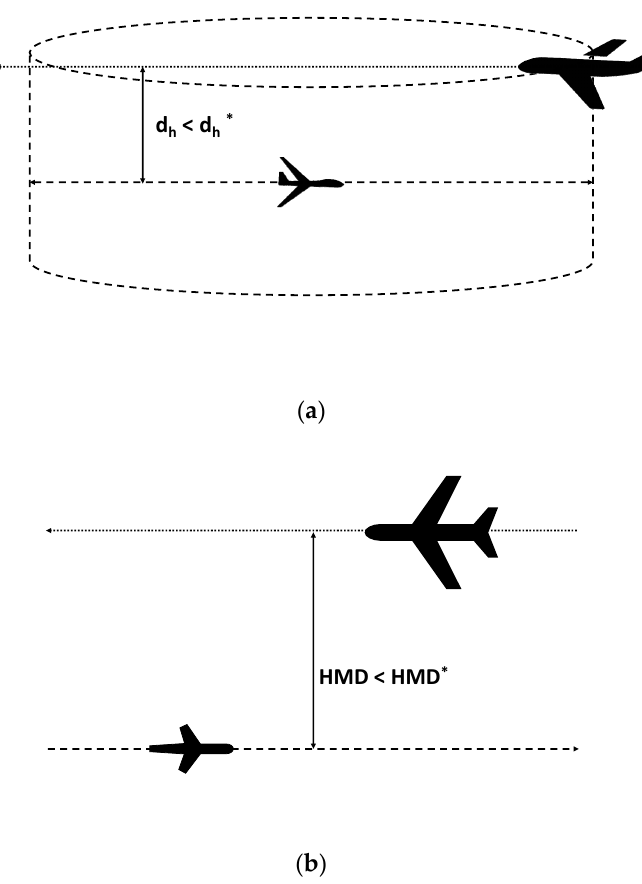
Figure 3. Loss of well clear in a head to head encounter. ( a ) Side view, ( b ) top view. The dashed objects/lines are projections of the future path.